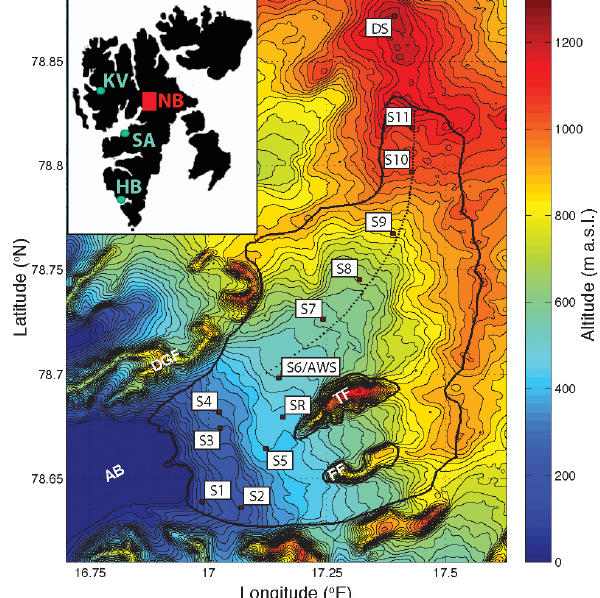
Fig. 1. Contour plot of the surface topography. The glacier out- line is indicated by the thick black line. Dark red squares mark the position of the stake sites (S1–11), the Automatic Weather Sta- tion (AWS), the Sonic Ranger (SR) and the ice core drilling site (DS). The location of De Geerfjellet, Terrierfjellet, Ferrierfjellet and the Adolfbukta fjord are denoted by DGF, TF, FF and AB, respec- tively. The dashed black line indicates the main flowline and cross- sectional subsurface profiles along this line are shown and discussed in Sect. 5.2. In the inset contour map of Svalbard, the locations of Nordenski¨oldbreen (NB), Hansbreen (HB), Kongsvegen (KV) and Svalbard Airport (SA) are